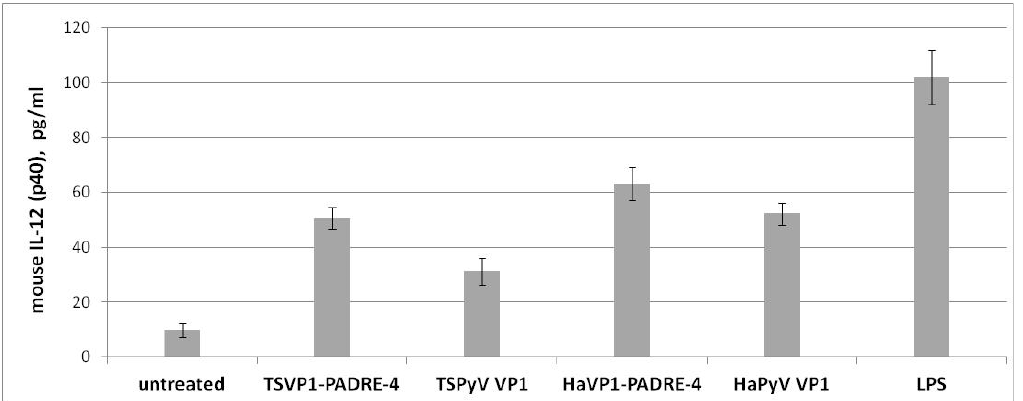
Figure 7. Production of IL-12 (p40) (pg/mL) by murine spleen cells incubated for 48 h with medium alone, TSVP1-PADRE-4 VLPs, unmodified TSPyV VP1 VLPs, HaVP1-PADRE-4 VLPs, unmodified HaPyV VP1 VLPs and LPS. Mean values and SD are indicated (n = 3).